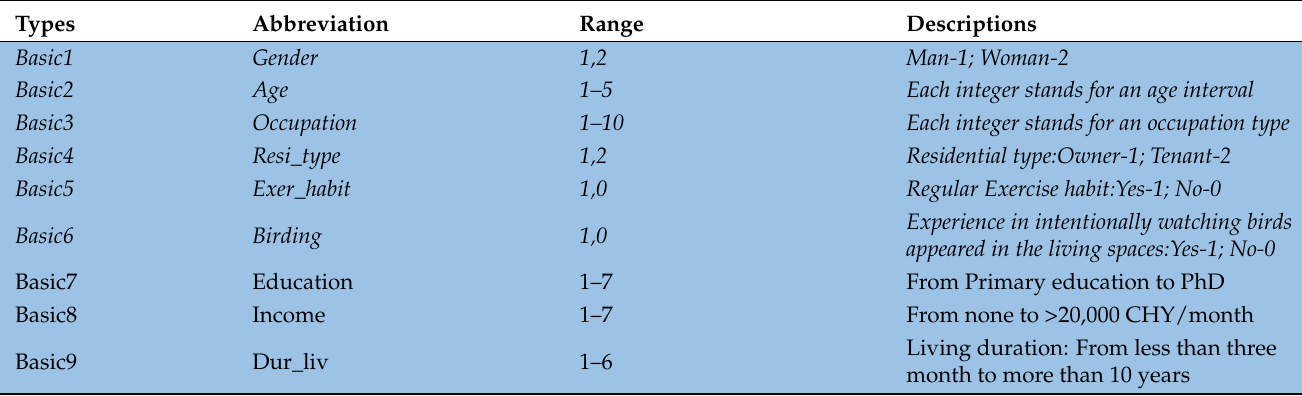
Table 1. Predictive variables used in our data analyses. The categorical variables are displayed in